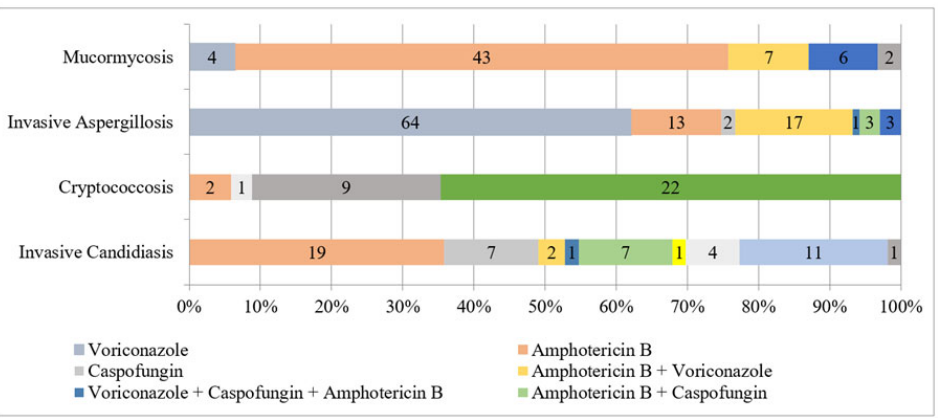
Figure 2. Antifungal treatment in IFI.